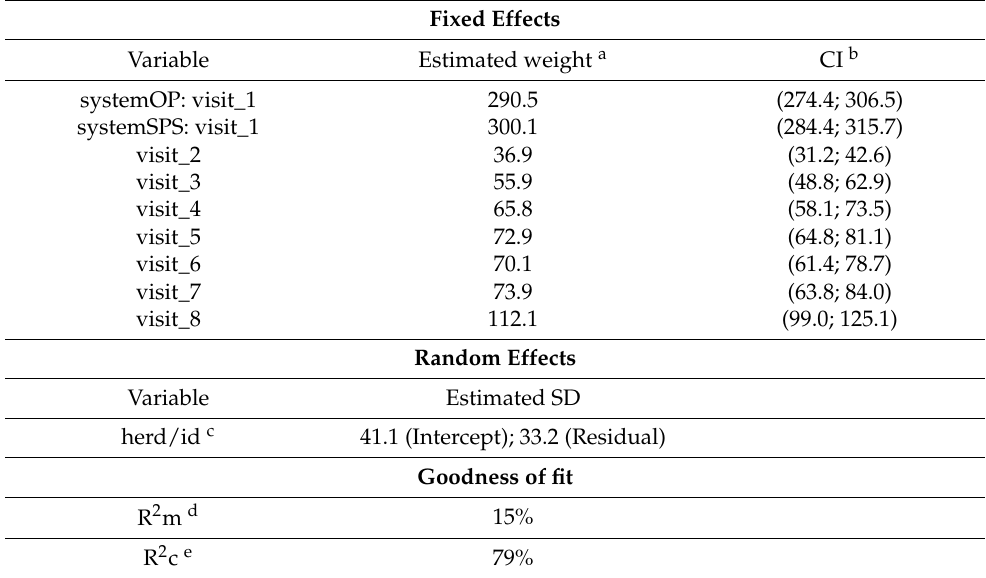
Table 3. Generalized linear mixed model (GLMM) results of weight means by system across eight visits. The values are presented in absolute terms for Visit 1, and from Visit 2 onwards, only the increases with respect to the initial one are shown (which were the same for each group).